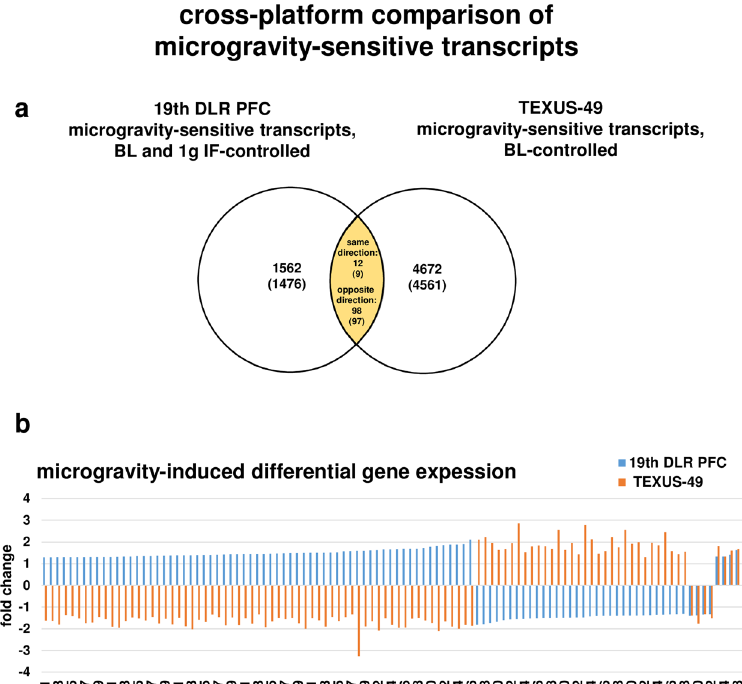
Figure 8. Microgravity sensitive transcripts are reversely regulated when comparing 20 s (19 th DLR Parabolic Flight Campaign) and 300 s (TEXUS-49 suborbital ballistic rocket campaign) exposure times. ( a ) Venn diagram showing the intersection of microgravity-sensitive transcripts of both platforms. ( b ) Graphical display of transcripts (annotated transcripts) showing that transcripts are mostly regulated in the opposite direction. Only 12 out of 110 transcripts are regulated in the same direction. Fold changes (FCs) are ratios between the averages of linear expression values. If the ratio is < 1, FC is calculated as the negative reciprocal of the